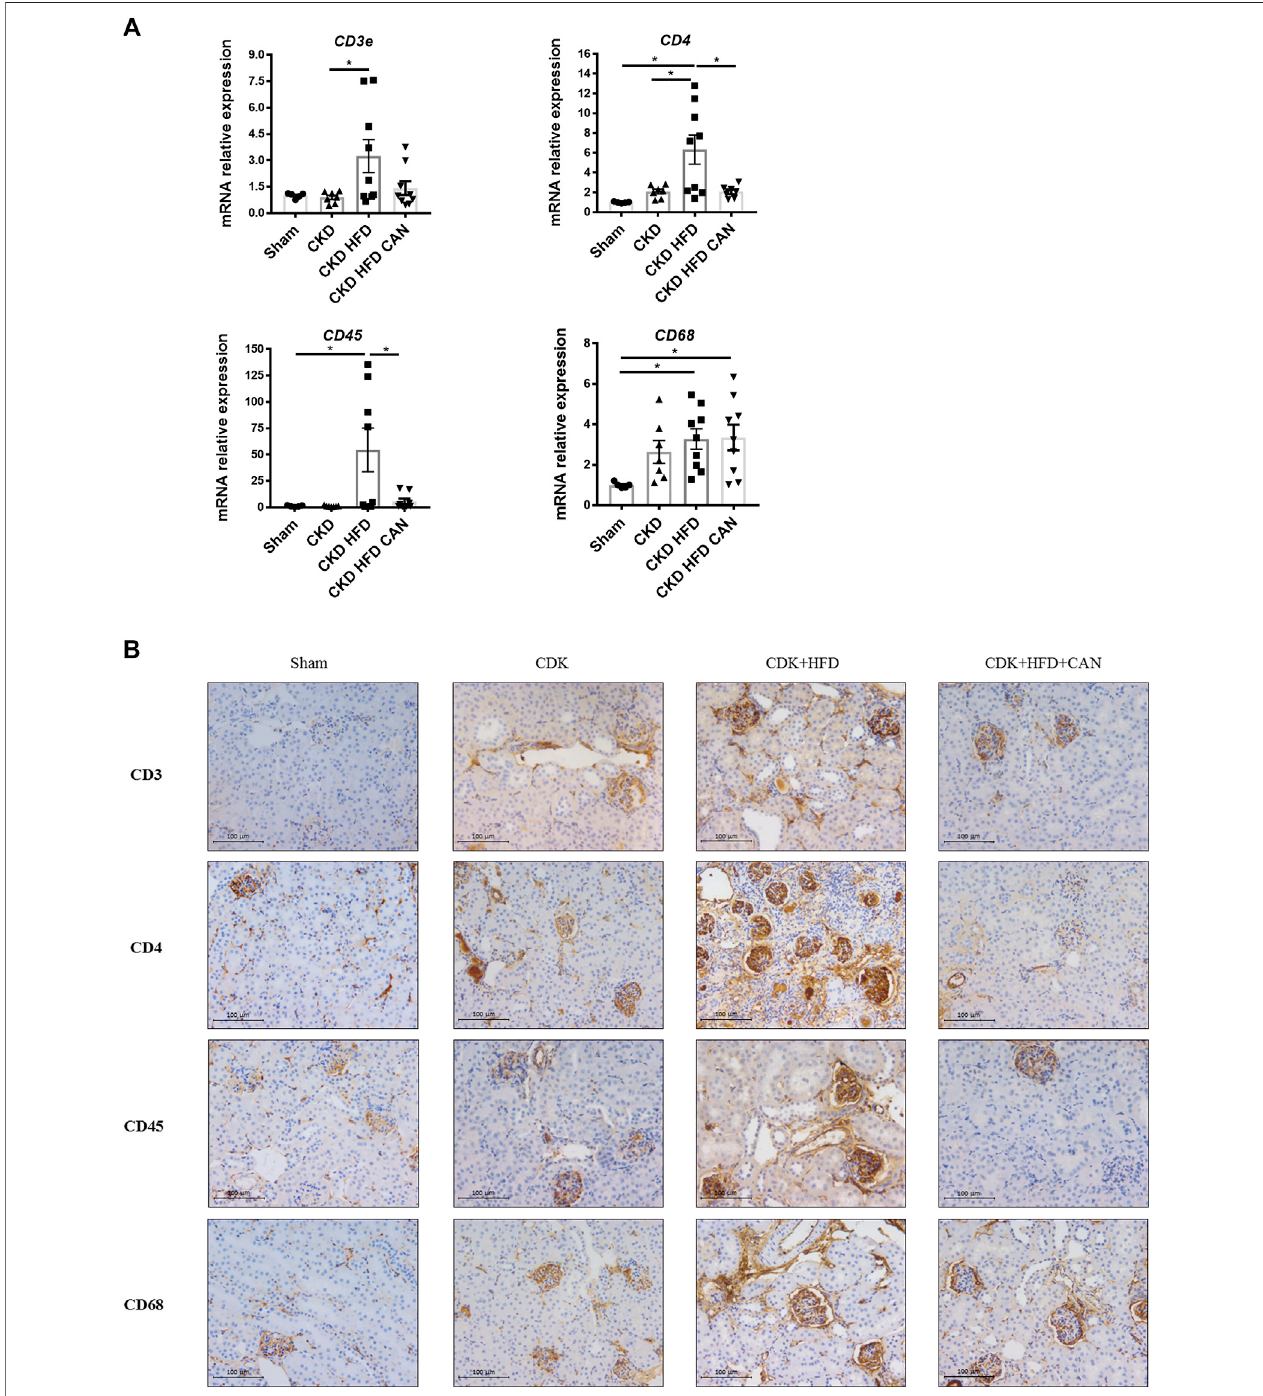
FIGURE 4 | Renal immune cell in fi ltration and effect of the MRA canrenoate. (A) mRNA levels of CD3, CD4, CD45 and CD68 (B) . Immunostaining of CD3, CD4, CD45 and CD68. Data represent the mean ± SEM. Statistical analysis by one-way ANOVA; with Tukey post-test, * p < 0.05 n = 5 – 9.